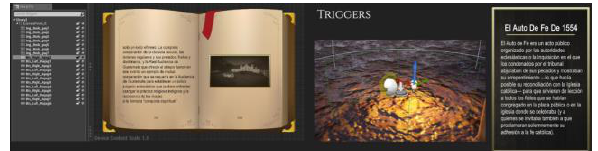
Figure. 5. Design of welcome menus and triggers to display posters with information about the buildings or processes present in the HRS.